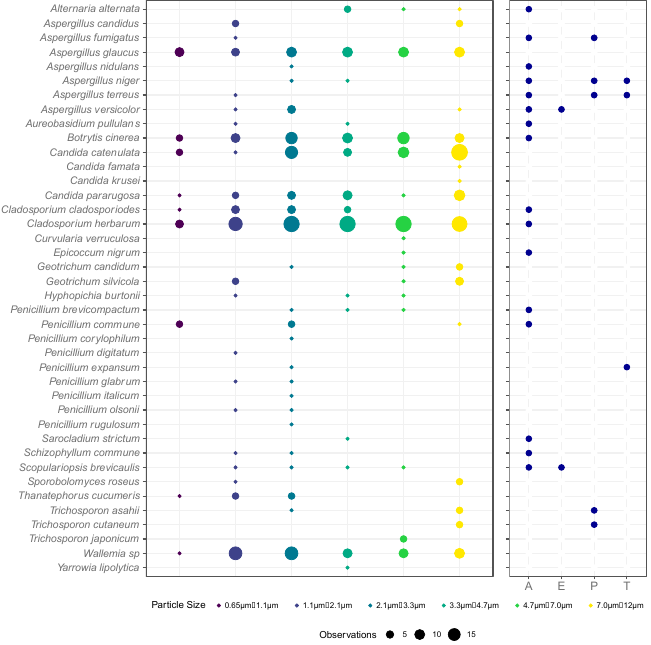
Figure 2. Bubble plots showing the total culturable microbial diversity amongst the four sampling days. On the left, each column represents the microbial diversity observed in the corresponding size fraction of the ACI-6 over the multiple sampling rounds, where the size of each circle represents the sum of the number of observations. The larger the circle, the more often that species was observed in that size fraction. On the right, attributes of the fungal species are given in regard to whether they are allergenic fungi (A), emerging pathogens (E), human pathogens from biological risk group 2 (P), or toxin producers (T). If not marked, then the species is not known to be allergenic, an emerging pathogen, a human pathogen, or a toxin producer. Species observed on all sampling days, included Botrytis cinerea, Candida paraguosa, Candida catenulata, Cladosporium herbarum, and Wallemia sp. Some species were observed to be unique to each sampling day, such as Aspergillus glaucus, which was found in every stage of the ACI-6 on the 17 th of July (Figure 2). In accordance with the German Technical Rules for Biological Agents (TRBA) 460, five species were categorized as being biological risk group 2 microorganisms. These included: Aspergillus